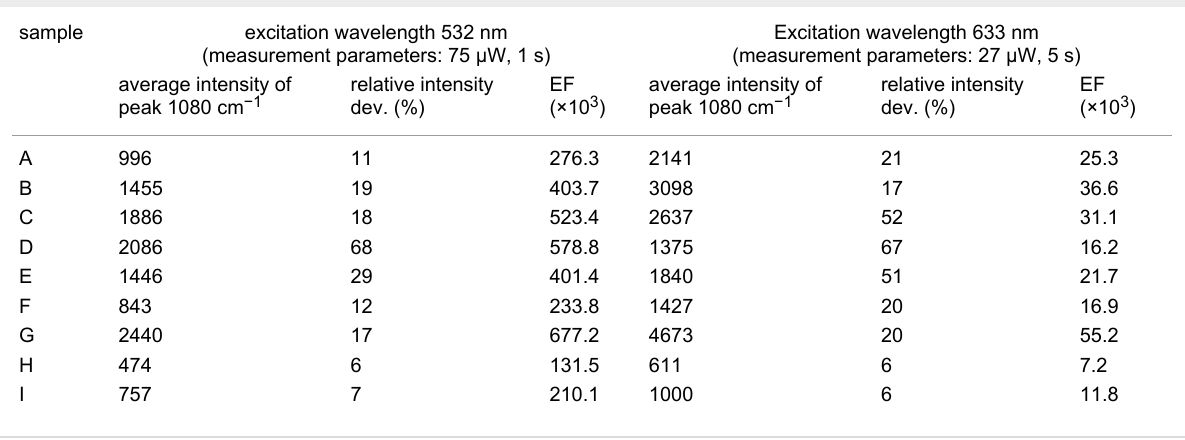
Table 2: Parameters of nanostructured silver layers determined based on SERS measurements. sample